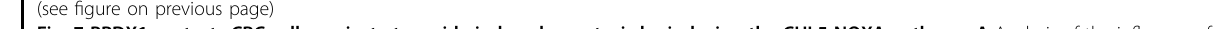
Fig. 7 PRDX1 protects CRC cells against etoposide-induced apoptosis by inducing the CUL5-NOXA pathway. A Analysis of the in fl uence of etoposide on CUL5 neddylation: HCT116 cells in 6-well plates were pretreated with etoposide (50 mM) for 0 – 4 h before being lysed for WB analysis. B Analysis of the in fl uence of etoposide on the NOXA degradation rate: HCT116 cells in 6-well plates were pretreated with etoposide (50 mM) for 1 h prior to CHX treatment for a fi xed duration before being lysed for WB analysis. The results are representative of three independent experiments, and band densities were quanti fi ed using Image Lab software and plotted using Prism 8 software (mean ± SD). C , D Inhibition of PRDX1 increased the sensitivity of HCT116 cells to etoposide-induced apoptosis: HCT116 cells infected with lentivirus expressing the indicated shRNAs were treated with 50 mM etoposide for 0 – 6 h and were then analyzed by fl ow cytometry ( C ) to detect apoptosis (mean ± SD; ** p < 0.01) or harvested for WB analysis ( D ) of NOXA and apoptosis marker proteins (cleaved PARP and cleaved c-Casp3). The results are representative of three independent experiments. E , F Overexpression of PRDX1 protected SW480 cells against etoposide-induced apoptosis: SW480 cells infected with the indicated pLenti-DNA recombinant lentiviruses were treated with 50 mM etoposide for 0 – 6 h and were then analyzed by fl ow cytometry ( E ) to detect apoptosis (mean ± SD; *** p < 0.001) or harvested for WB analysis ( F ) of NOXA and apoptosis marker proteins (cleaved PARP and cleaved c-Casp3). The results are representative of three independent experiments. G The increase in CUL5 neddylation induced by etoposide was PRDX1-dependent: HCT116 cells infected with lentivirus expressing the indicated shRNAs were treated with 50 mM etoposide for 0 – 6 h and were then harvested for WB analysis of CUL5 neddylation. H A working model: PRDX1 protects CRC cells against etoposide-induced apoptosis by inducing the UBE2F-CUL5-NOXA